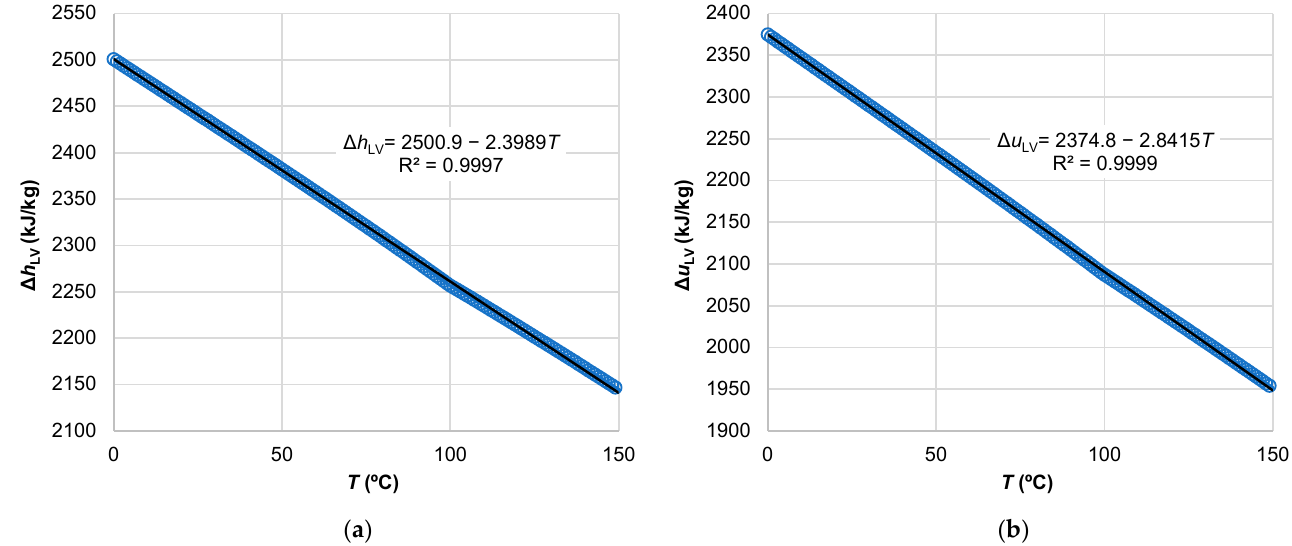
Figure 4. ( a ) Enthalpy of vaporisation Δ h LV , and ( b ) difference in internal energy between vapour and liquid water Δ u LV , for temperatures between 0 and 150 °C. Markers: reference values from [13]. Line and equation: best linear fit.